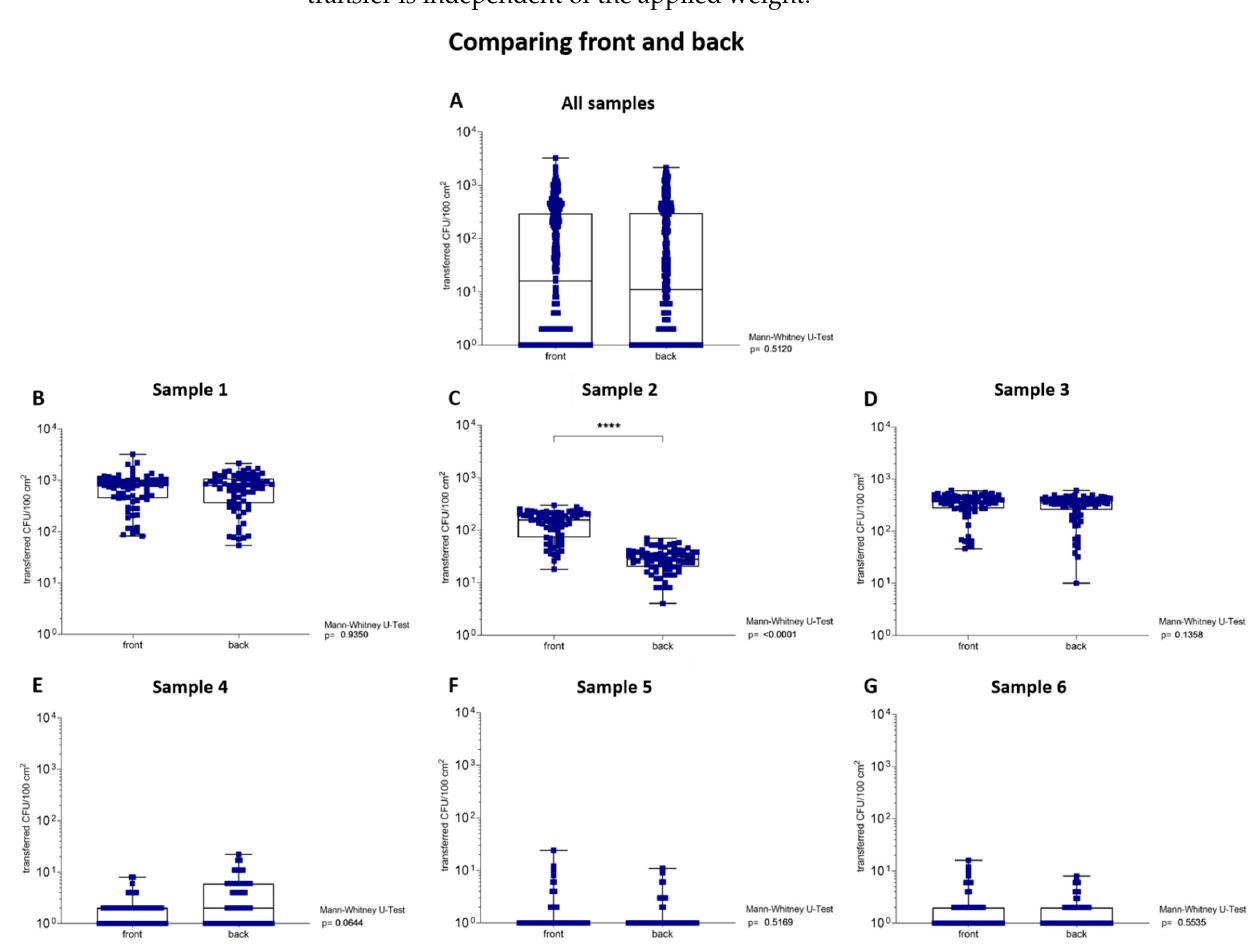
Figure 3. Comparison of the transfer of colony-forming units per 100 square centimeters (CFU/100 cm 2 ) from the front and back of packaging materials to contact media. The samples are listed in increasing order. The nodes (blue) depict transferred CFU/100 cm 2 from the outer layers of the packaging material to the TSA plates after the samples were loaded with 100 g, 150 g, 200 g and 250 g for 30 min, or loaded with 250 g for 5 min, 10 min, 15 min, 20 min and 30 min. A p -value below 0.05 was defined as statistically significant. ( A ) No significant difference was calculated between front and the back when summarizing all data ( p < 0.01). ( C ) In contrast, when analyzing the data of each sample, a significant difference ( p < 0.01) between front and back was calculated for sample 2. ( B , D – G ) The evaluations for samples 1 and 3–6 revealed no significant difference ( p > 0.05) between both tested outer layers. **** indicates statistical significance with a p -value below 0.0001.